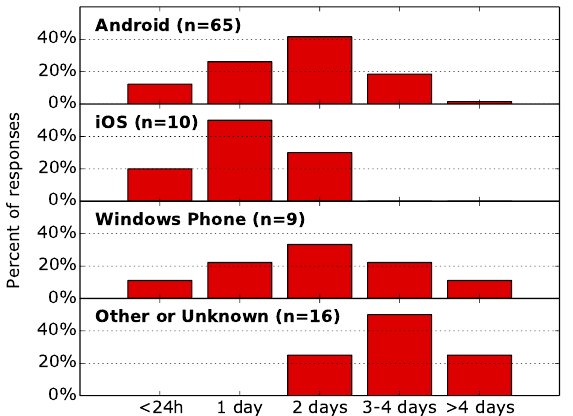
Figure 1. Single choice question: “In a typical daily usage, how long is your mobile phone able to work?”